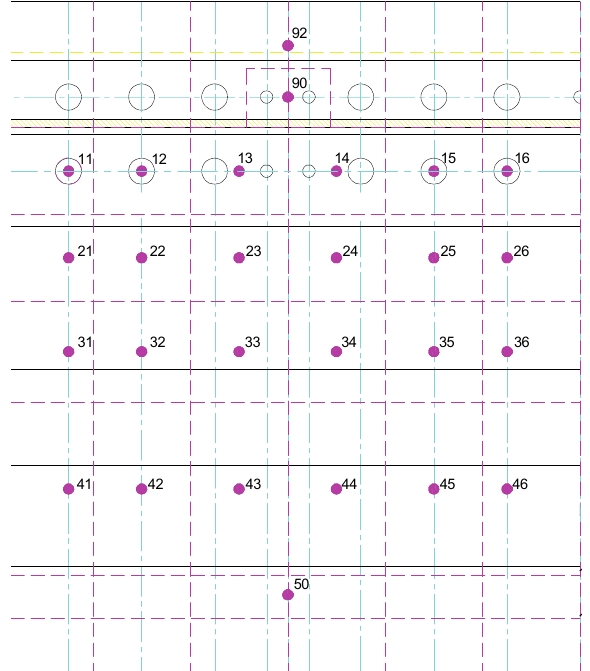
Figure 6: Locations of thermal-hydraulic data supplying points at the inner surface of the